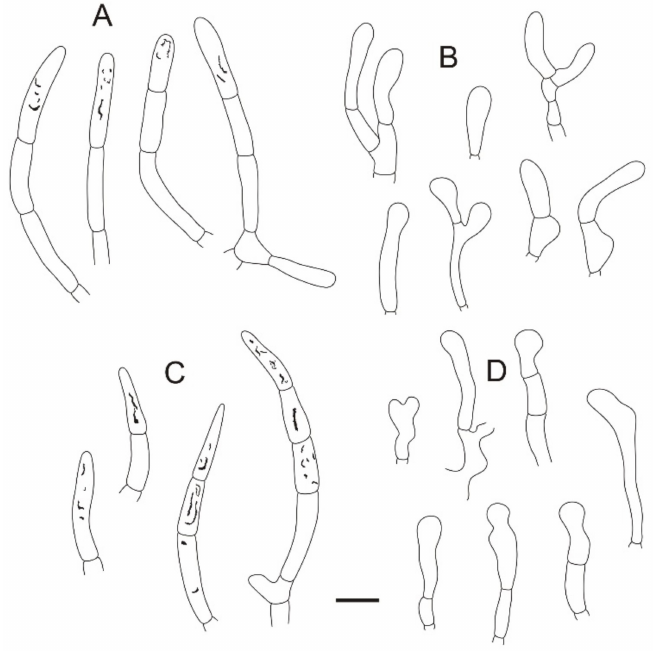
Figure 9. Microscopic features of Russula plana (BJTC Z1398). ( A ) Primordial hyphae near the pileus margin. ( B ) Hyphal terminations near the pileus margin. ( C ) Primordial hyphae near the pileus center. ( D ) Hyphal terminations near the pileus center. Scale bar: 10 µ m. Etymology: The epithet “ plana ” refers to the flat pileus of the basidiomata after maturity. Basidiomata: small size, pileus 19–43 mm in diameter, initially hemispherical when young, applanate with depressed in the center when mature, recurved in age, smooth, sticky when wet, peeling to 1/5 of the radius. brick-red (#c62d42) to deep red (#622f30), sometimes red (#ff1a1a), margin light pink (#d69188). Lamellae: cream (#ffffff), yellow (#ffffed) in age, adnate to adnexed, lamellulae absent, hardly forked. Stipe: 23–41 × 6–13 mm, white (#ffffff), cylindrical, smooth, firm. Context: 5–10 mm thick in half of the pileus radius, white (#ffffff), without color change when bruised. Spore print: not